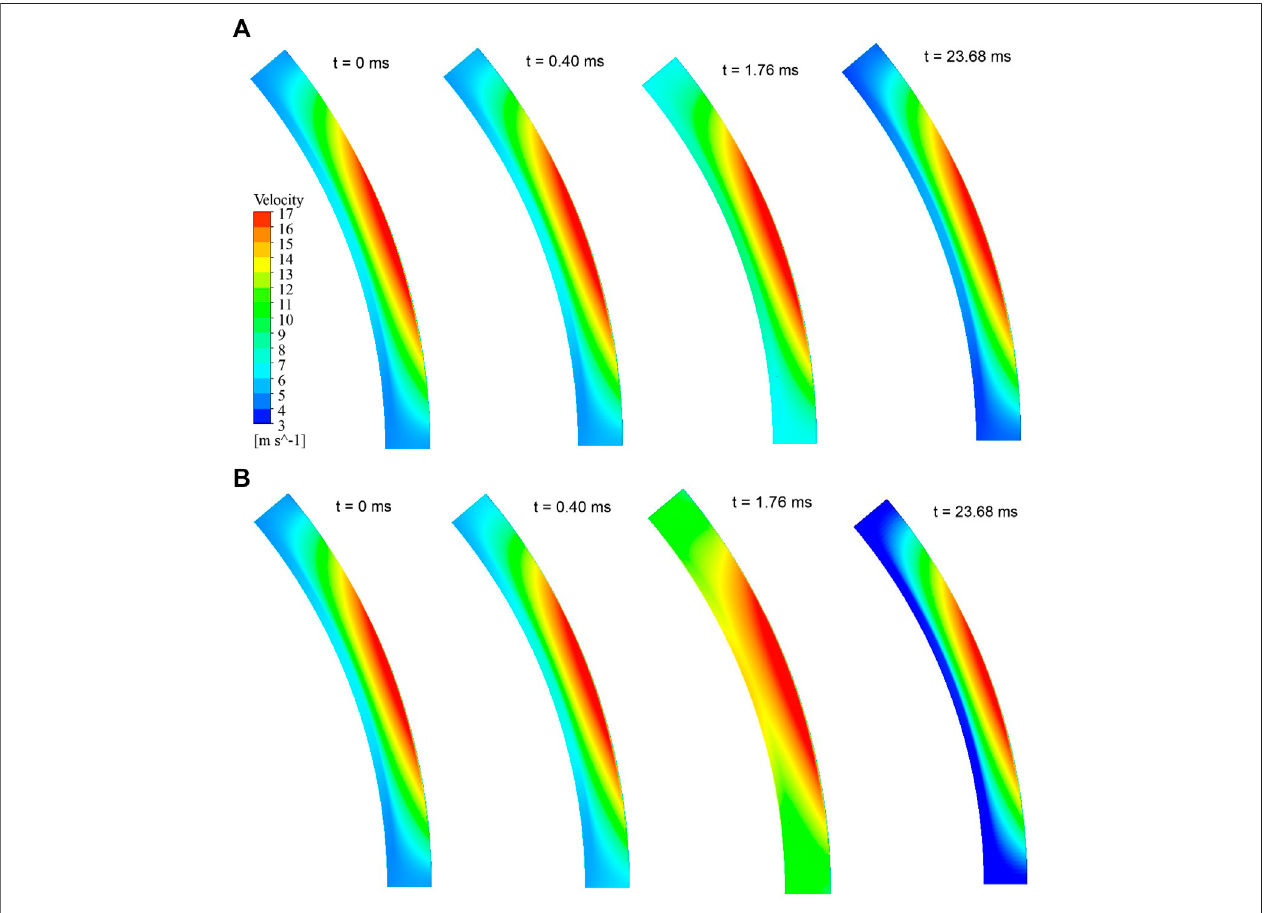
FIGURE 14 | Velocity distribution varies with time (A) a = 4% and (B) a =